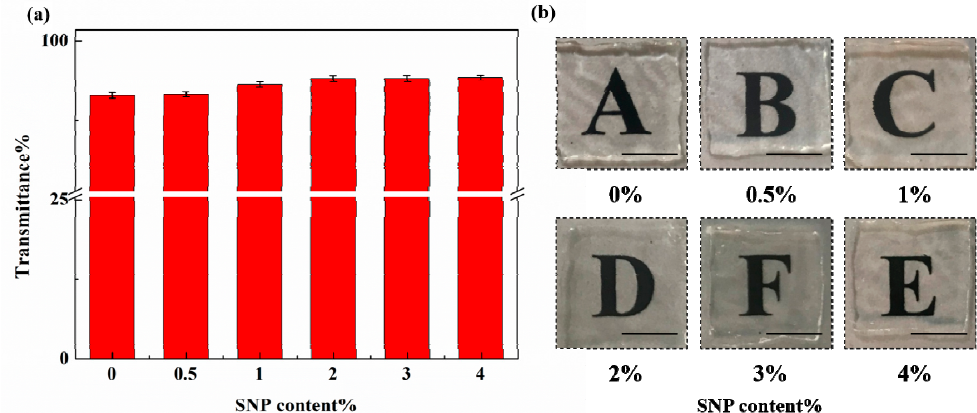
Figure 5. Transparency of SNP-reinforced ionogels with different contents of SNP: ( a ) integral transmittance of ionogels (from 300 nm to 700 nm) with various SNP contents; ( b ) digital photos of ionogels with various SNP contents.